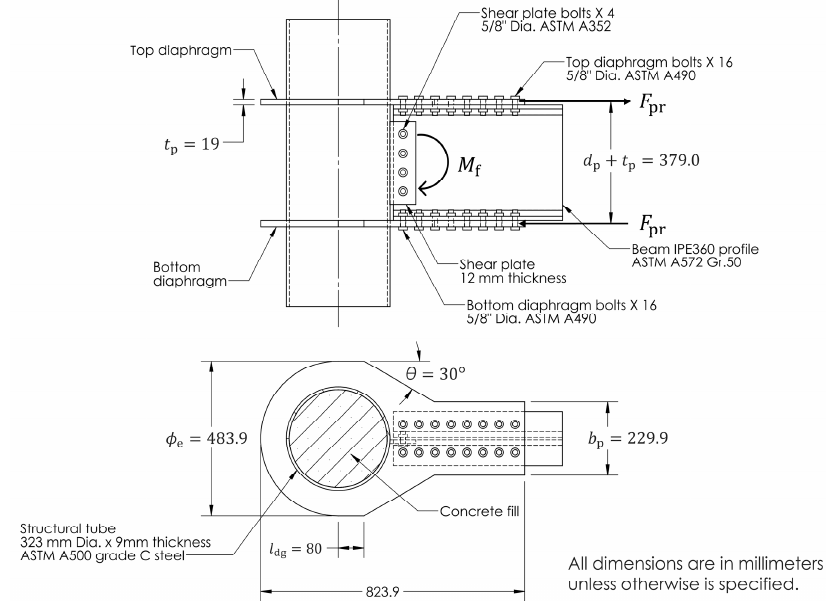
Figure 2. Components and main dimensions of the connection obtained from the design process. The action of the maximum capacity force F pr and the maximum probable moment M f are also illustrated.